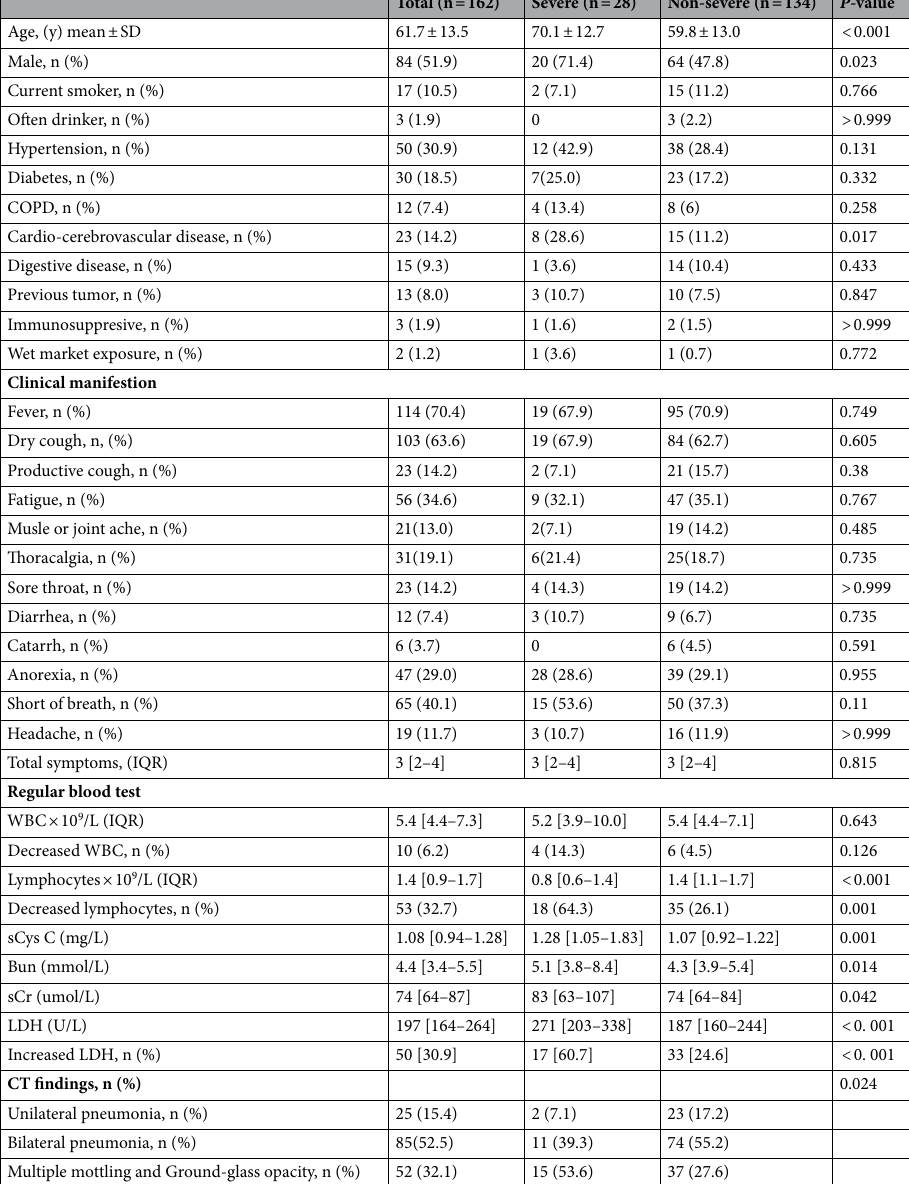
Table 1. Characteristics at baseline among severe and non-severe COVID-19 patients. Legend and abbreviations: COVID-19 = coronavirus disease 2019; SD = Standard deviation; COPD = Chronic obstructive pulmonary disease; IQR = Interquartile range; WBC = white blood cell (10 9 /L; reference range 3.5–9.5); Lymphocytes (× 10 9 /L; reference range 1.1–3.2); sCys C = serum cystatin C (mg/L, reference range